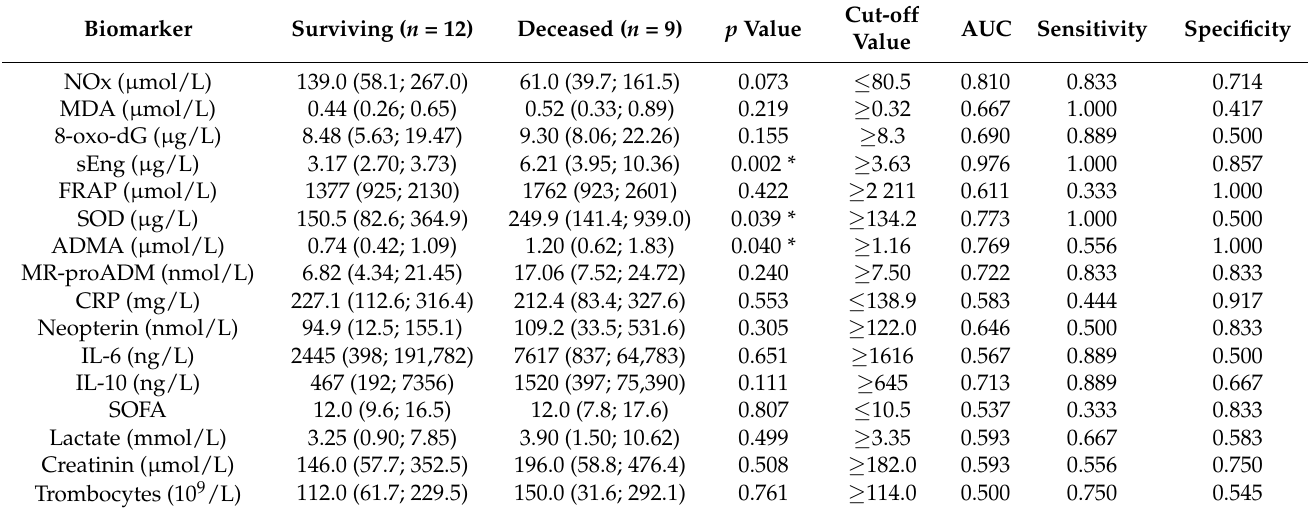
Table 2. Comparison of oxidative stress biomarkers and clinical characteristics values (at admission —T1) in surviving and deceased patients and their ability to predict 3-month mortality according to C-statistics.